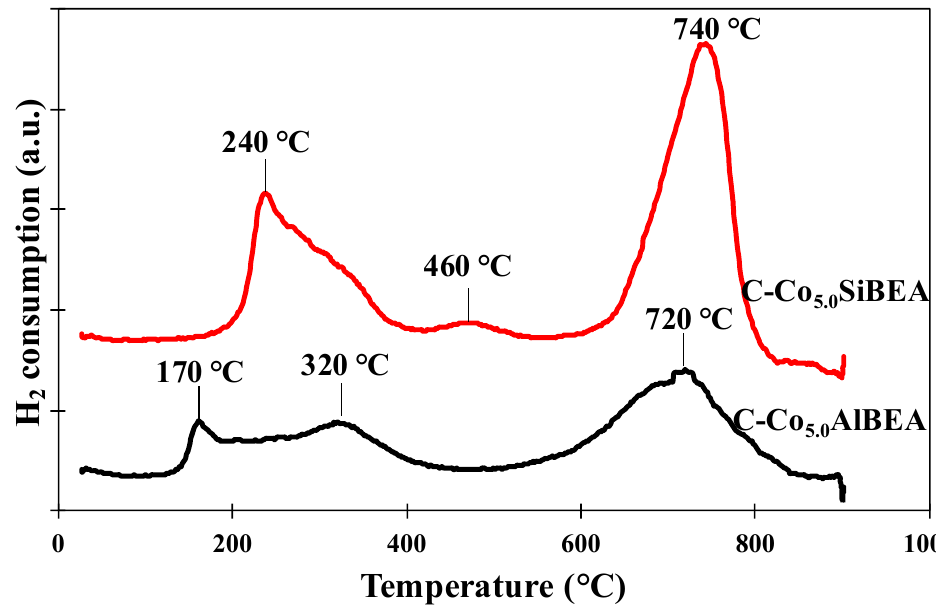
Figure 2. TPR-H 2 profiles of C-Co 5.0 AlBEA and C-Co 5.0 SiBEA performed in the temperature between 25 and 900 ◦ C showing that C-Co 5.0 SiBEA is hardly reduced than C-Co 5.0